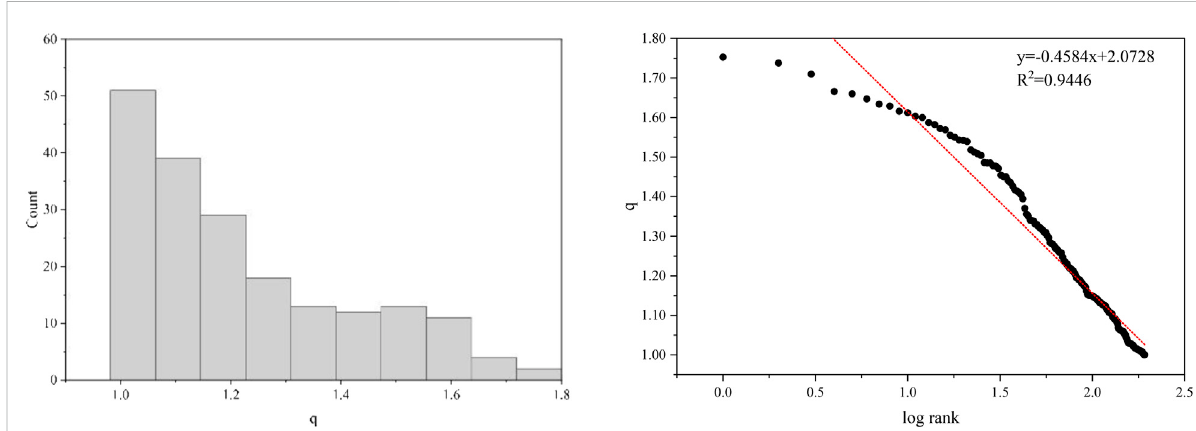
FIGURE 7 q value of all 192 cases of traditional houses in Haimen and Jiazhi.